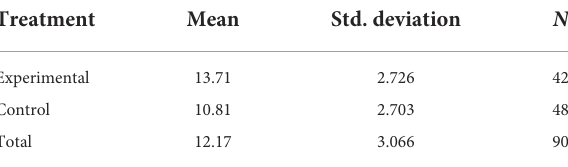
TABLE 4 Mean and standard deviation of academic performance of chemistry taught with cultural practices resources and conventional method.